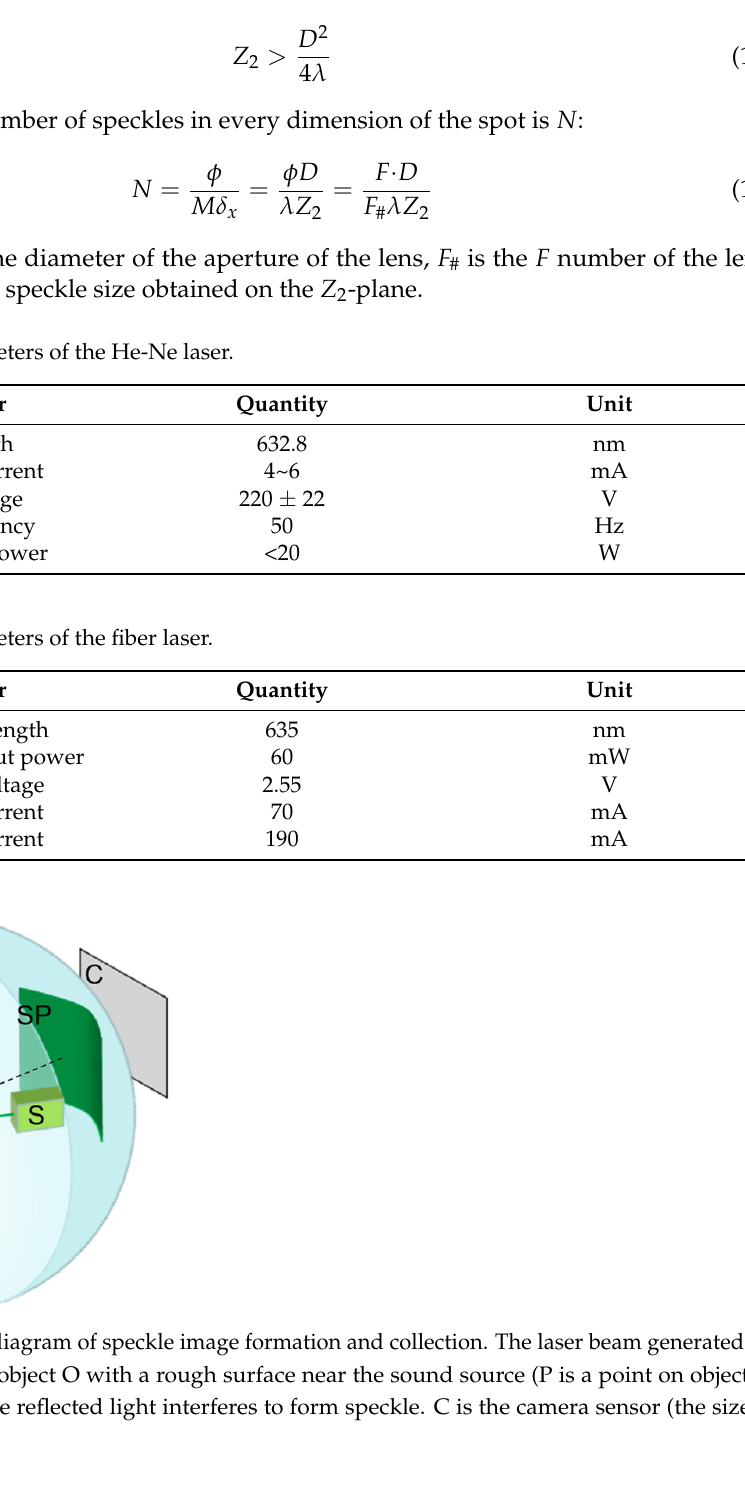
Figure 9. Experimental setup diagram. The laser beam generated by laser A is projected onto object M on the N platform. The change of speckle is collected by B camera, and these images are trans ‐ mitted to the D computer through the C interface to extract the movement between speckle images. Figure 10. Simulation diagram of the He ‐ Ne laser system. Figure 11. Simulation diagram of the fiber laser system.